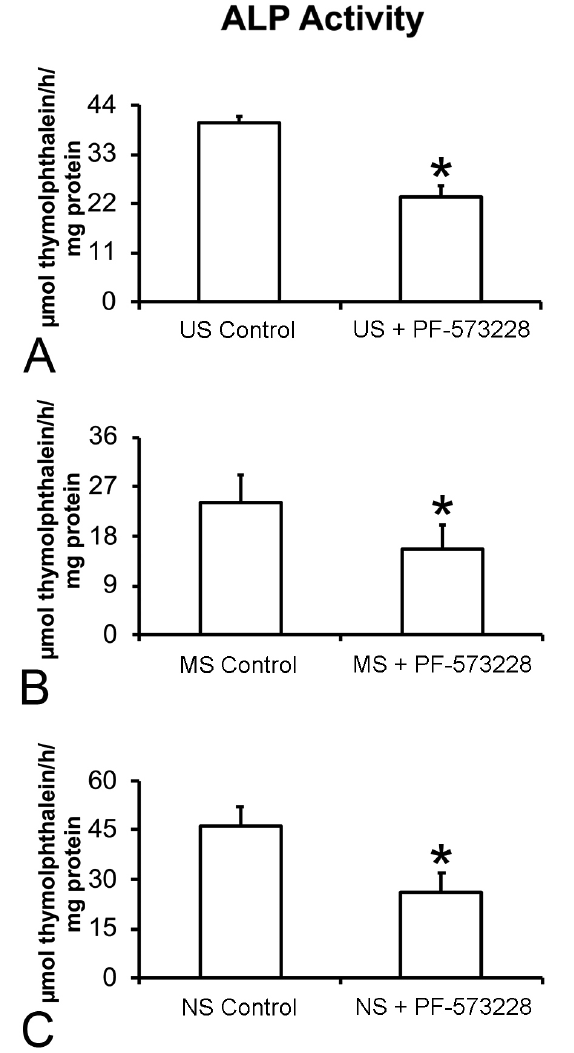
Figure 6- Alkaline phosphatase (ALP) activity of cells cultured on US (A), MS (B), and NS (C) in the presence or absence of 0.1 µM PF-573228 on day 10. The data are presented as mean ± standard deviation (n=3), and asterisks (*) indicate statistically significant differences